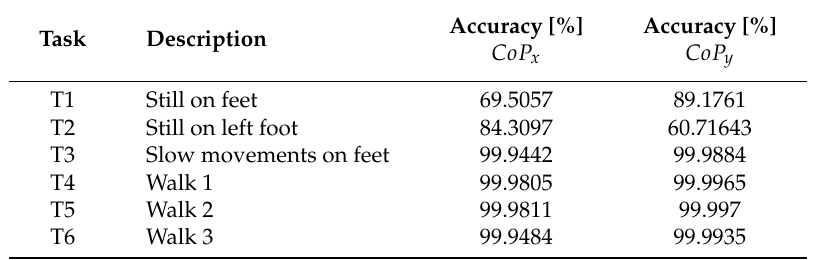
Table 4. Tracking accuracy of centre of pressure CoP x , CoP y , respectively, from task T1 to